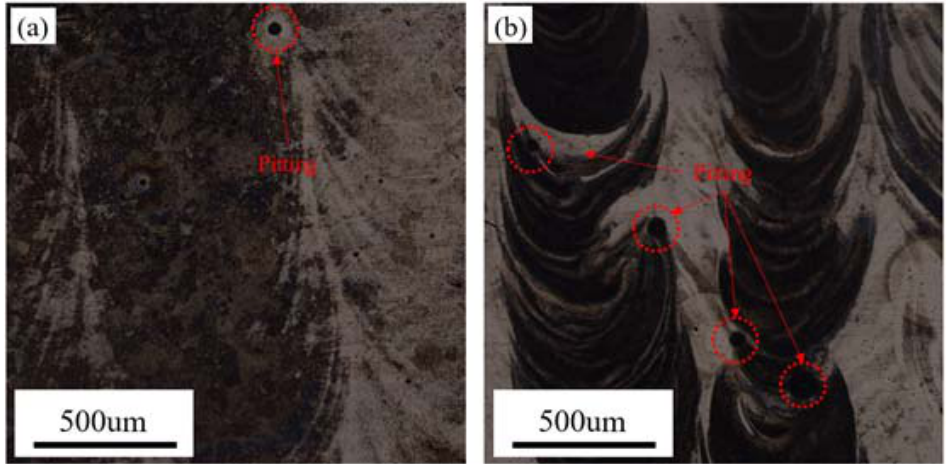
Figure 10. OM images of the LMD HEA after electrochemical tests: ( a ) XY ‐ plane and ( b ) YZ ‐ plane.